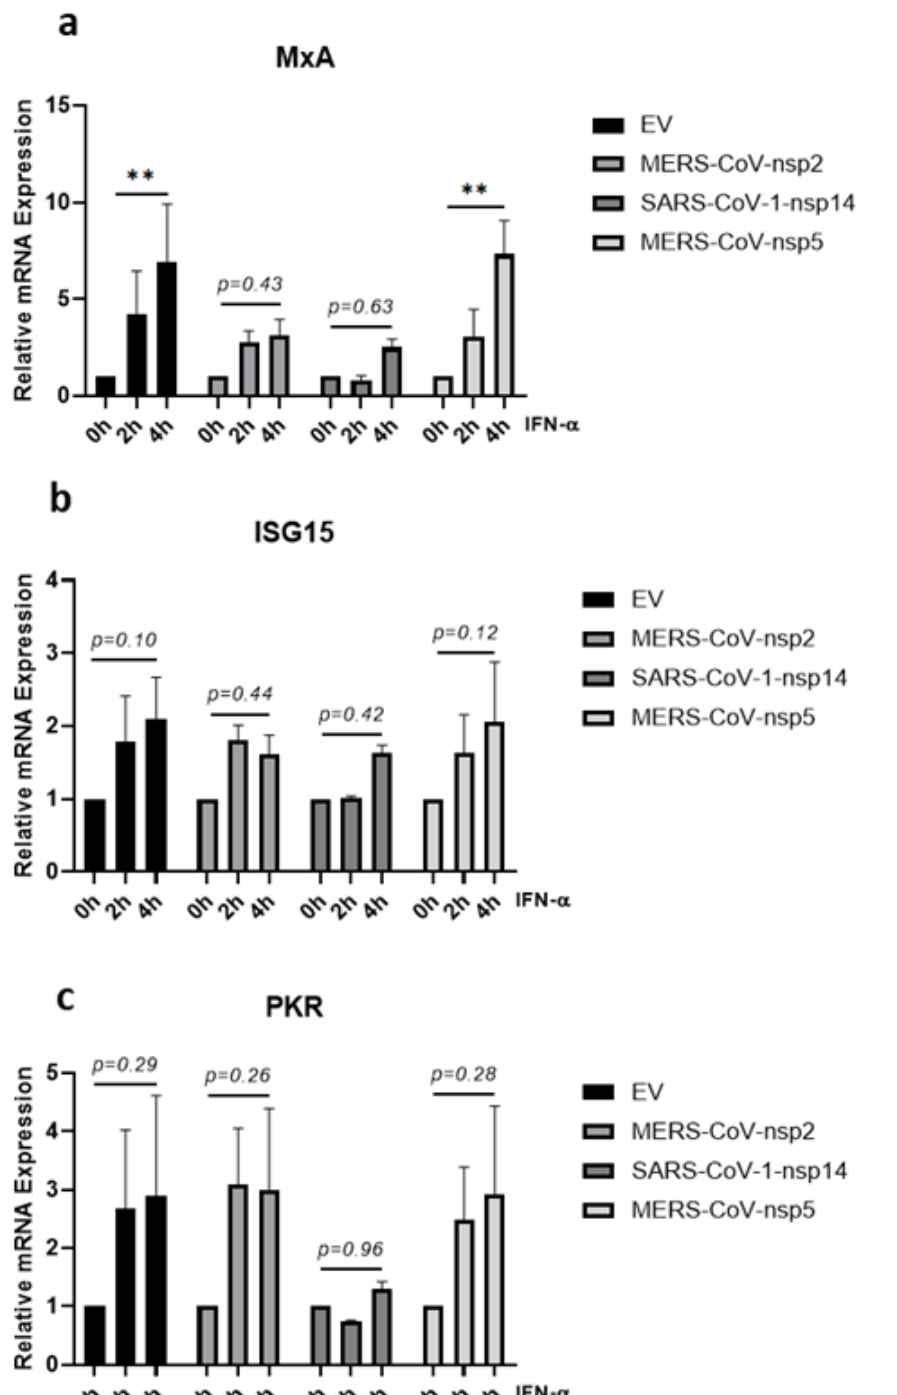
Figure 4. MERS-CoV-nsp2 and SARS-CoV-1-nsp14 expression impair IFN- α -mediated MxA induction in A549 cells. A549 cells were transfected with Empty Vector (EV) or HA-tagged MERS-CoV-nsp2, SARS-CoV-1-nsp14, or MERS-CoV-nsp5. After 24 h, cells were treated for 2 or 4 h with IFN- α (1000 U/mL) before analysing: ( a ) MxA, ( b ) ISG15, and ( c ) PKR mRNA by qRT-PCR. Gene expression was normalised to house-keeping gene RPS15 and IFN- α treated samples were compared to the untreated control (IFN- α 0 h), which was normalised to 1. All graphs are the mean ± SEM of three independent experiments. ** p < 0.01 (Two-way ANOVA).